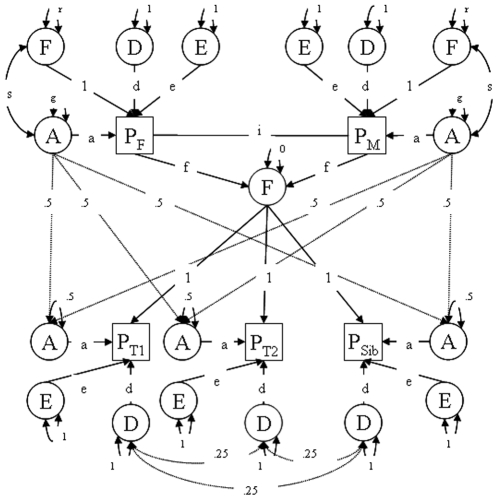
Path diagram of phenotypic assortment model with genetic and cultural transmission from parents to offspring.Squares represent the phenotypes of a DZ twin pair (PT1 and PT2) with one extra sibling (PSib), and both parents (PF and PM). Latent factors are represented by circles and include A (additive genetic factor), D (dominance genetic factor), and E (non-shared environment). F represents vertical cultural transmission whereby the phenotype of the parents influences the environment of their offspring. Assortment of parents is modeled as a copath (i). Simultaneous genetic and cultural inheritance induces a correlation (s) between this environmental factor F and the genetic factor A. Path coefficients a, d and e represent the influence of latent factors on the phenotype. The variance due to vertical cultural transmission is represented by r and the variance of additive genetic factors by g.